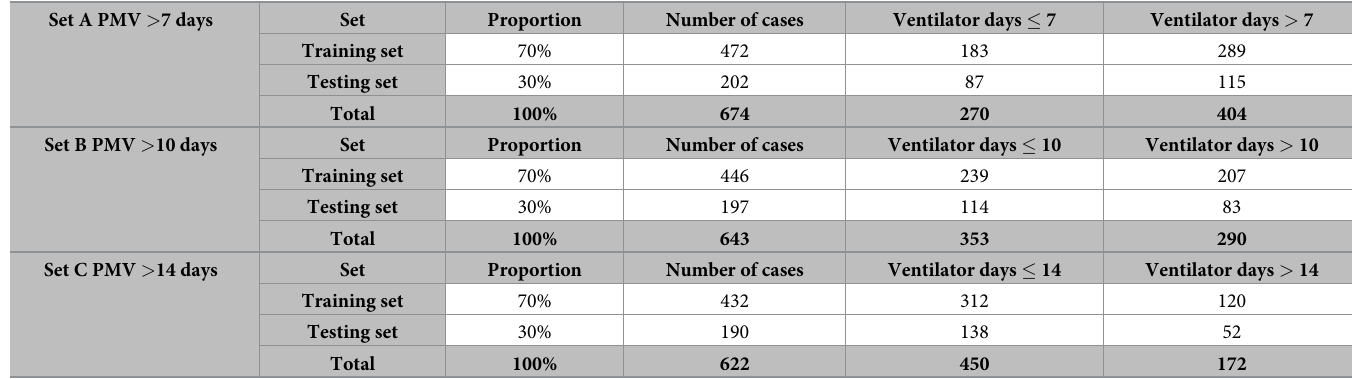
Table 2. Data partitions.